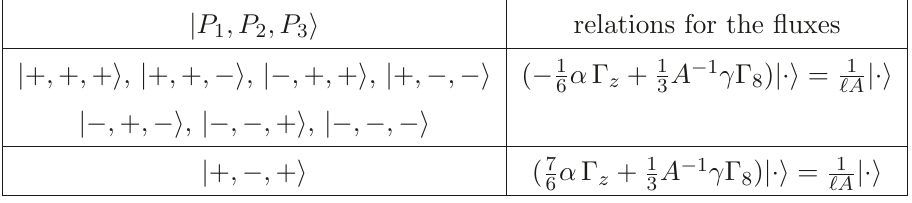
Table 4 . Decomposition of (3.41) KSE into